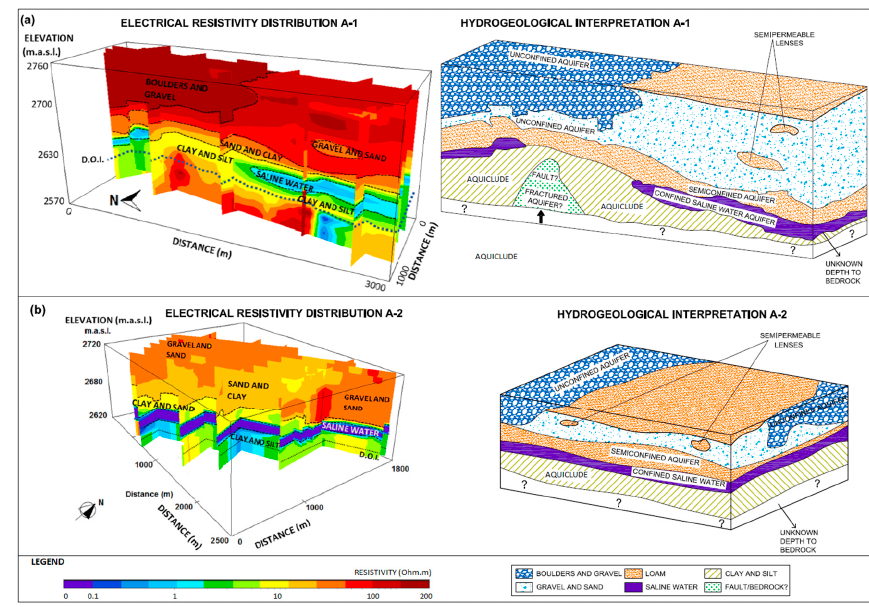
Figure 7. ( a , b ) Electrical resistivity and hydrogeological interpretation for A-1 and A-2, respectively (refer to Figure 1a for location). Figure 1a for